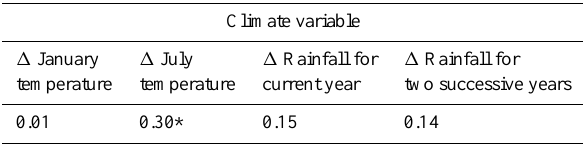
Table 2. Correlation coefficients ( ∗ p <0.01) between the direct in- dex of needle cast and climate anomalies ( (cid:49) ) estimated in each year at each forest